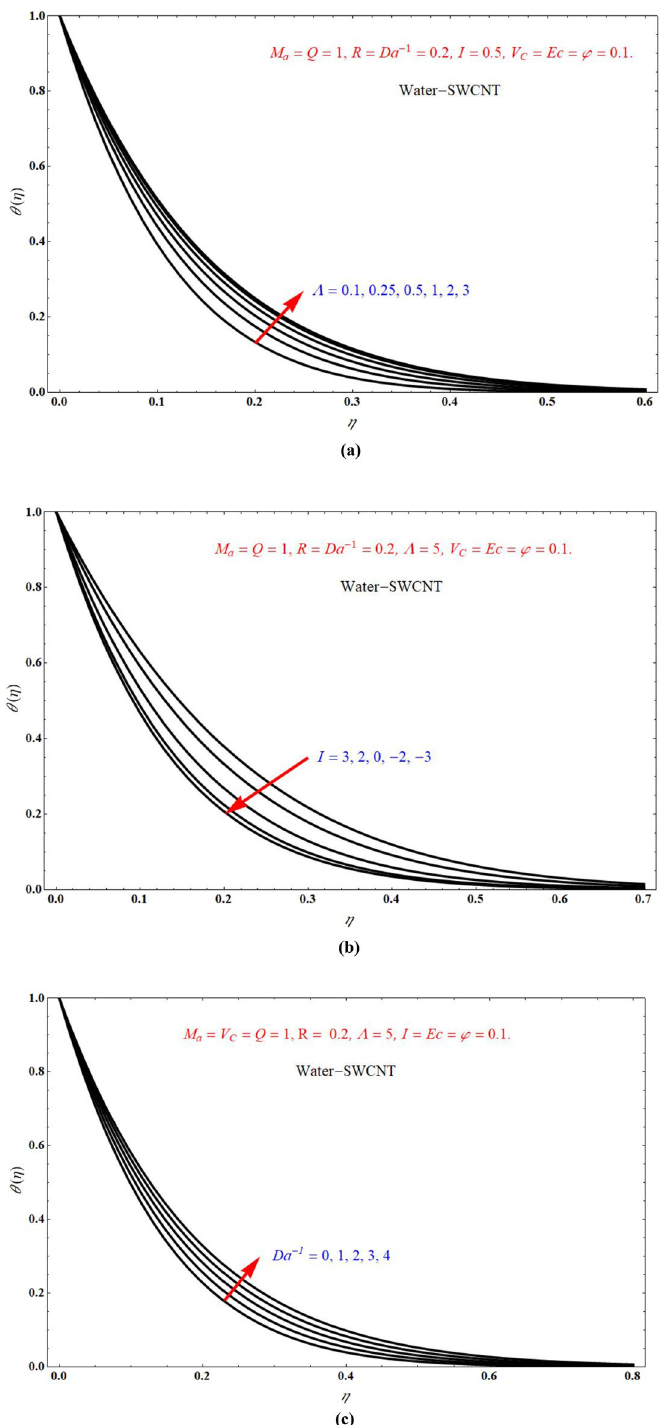
Figure 11. θ(η) verses η for various values of ( a ) (cid:31) ( b ) I and ( c ) Da − 1